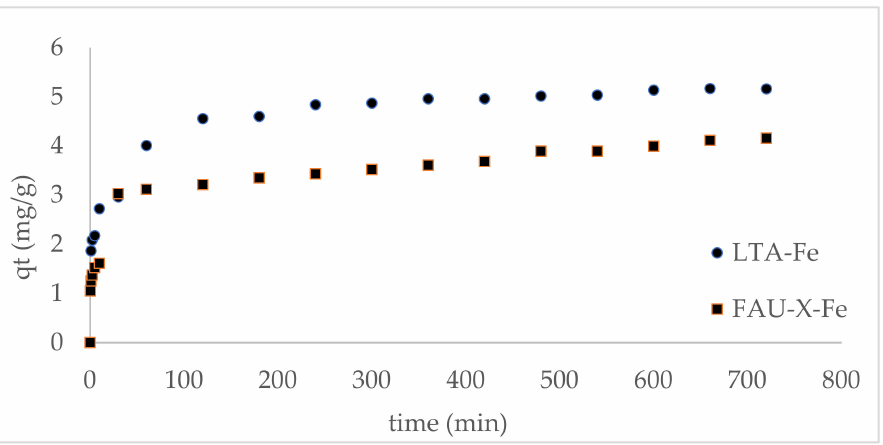
Figure 7. Kinetic profile of phosphate adsorption onto LTA-Fe and FAU-X-Fe (V: 25 mL, w: 0.25 g, and Ci: 25 mg PO 4 3 − L − 1